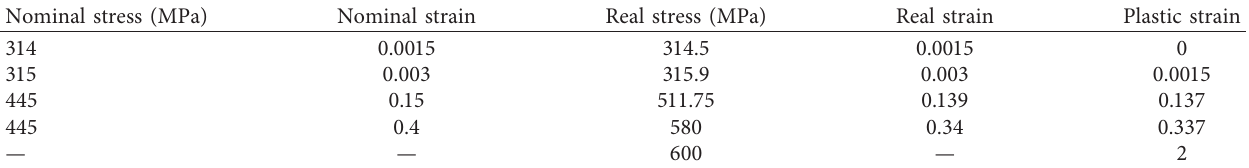
Table 7: Transformation of nominal and real stain and stress of the steel.